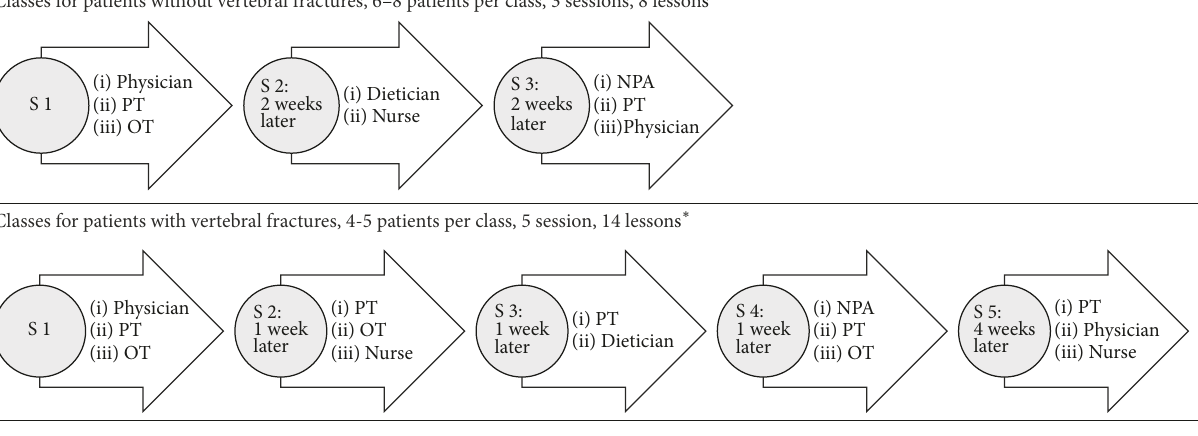
Figure 1: Multidisciplinary osteoporosis group educational programmes: sessions, lessons, and teachers. ∗ Length of lessons is 45 minutes; NPA, National Patients Association; PT, physiotherapist; OT, occupational therapist; S,